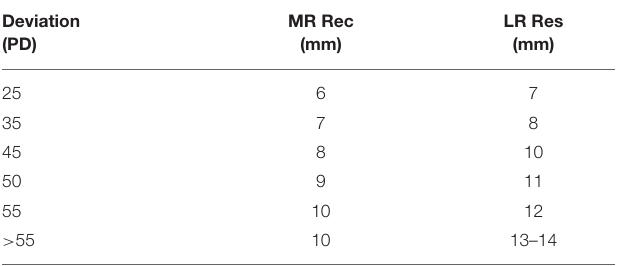
TABLE 1 | Surgical dosage form of supramaximal R-R operation. Deviation